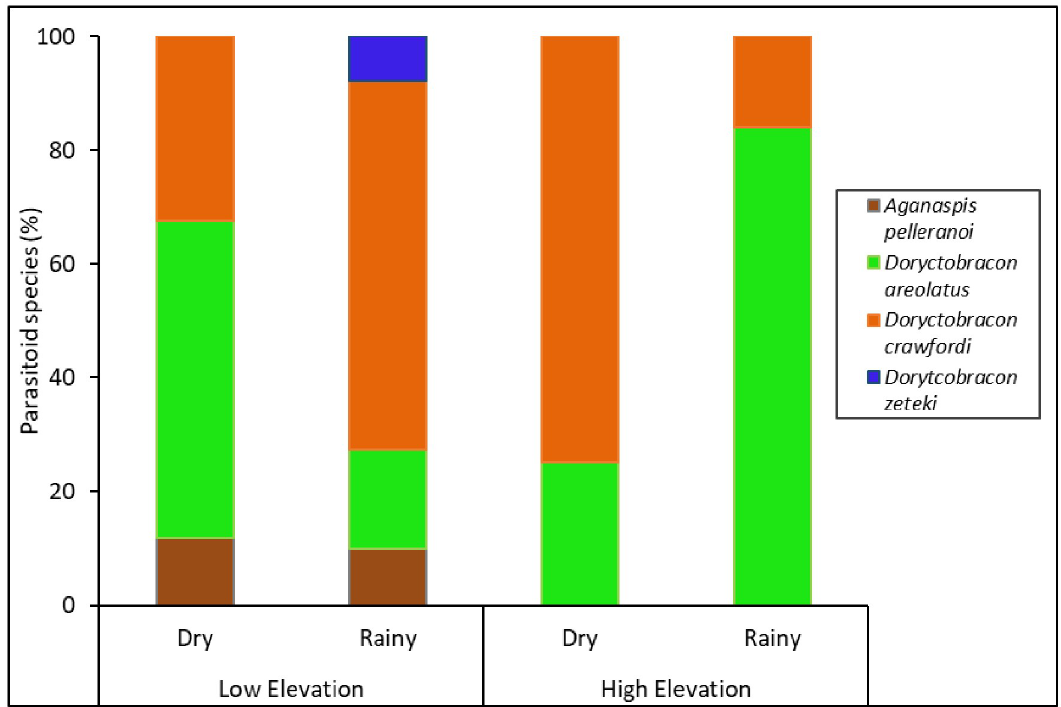
Fig 6. Fruit fly parasitoid species composition in fruit. Percentage of fruit fly larval parasitoids that emerged from guava fruit collected at different elevations (low and high) and seasons (dry and rainy) from 2013–2014.